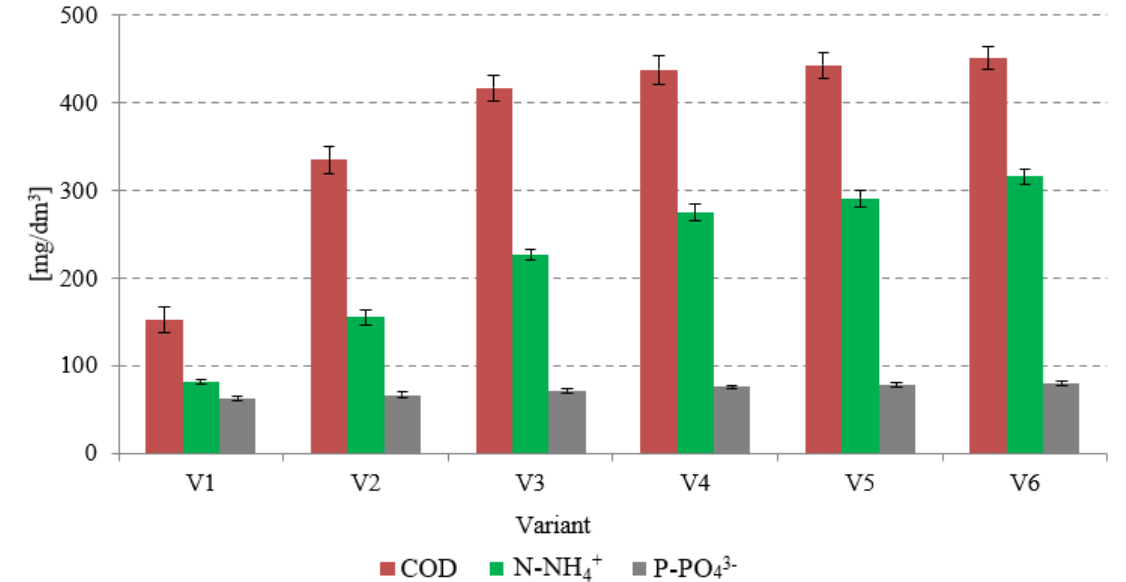
Figure 5. Changes in concentrations of organic compounds and nutrients in AGS supernatant caused by the pre-treatment with SCO 2 .